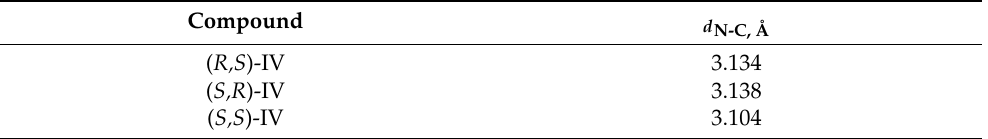
Table 11. Distances between the nitrogen atom of the tryptophan fragment and the carbon atom of the ketoprofen